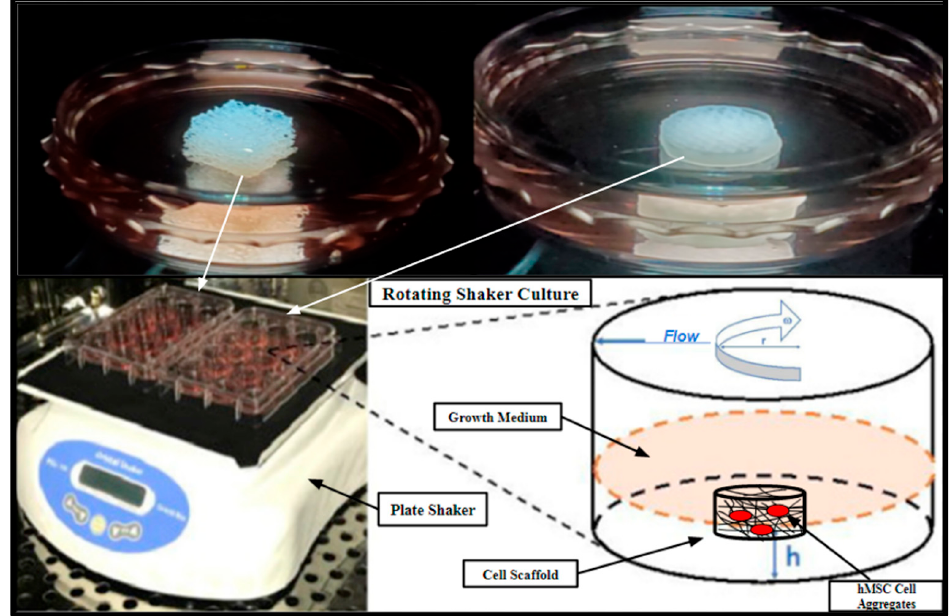
Figure 13. Rotating shaker culture of fertilized PCL scaffolds and Allowash ® cancellous cubes at 5 rpm to allow for culture medium flow through the scaffold matrices. The top two images are of the cancellous bone cubes ( left ) and PCL honeycomb scaffold ( right ). The bottom left is a photograph of the rotating shaker culture apparatus (VWR Microplate Shaker), and the bottom right is a schematic demonstrating the desired culture conditions.